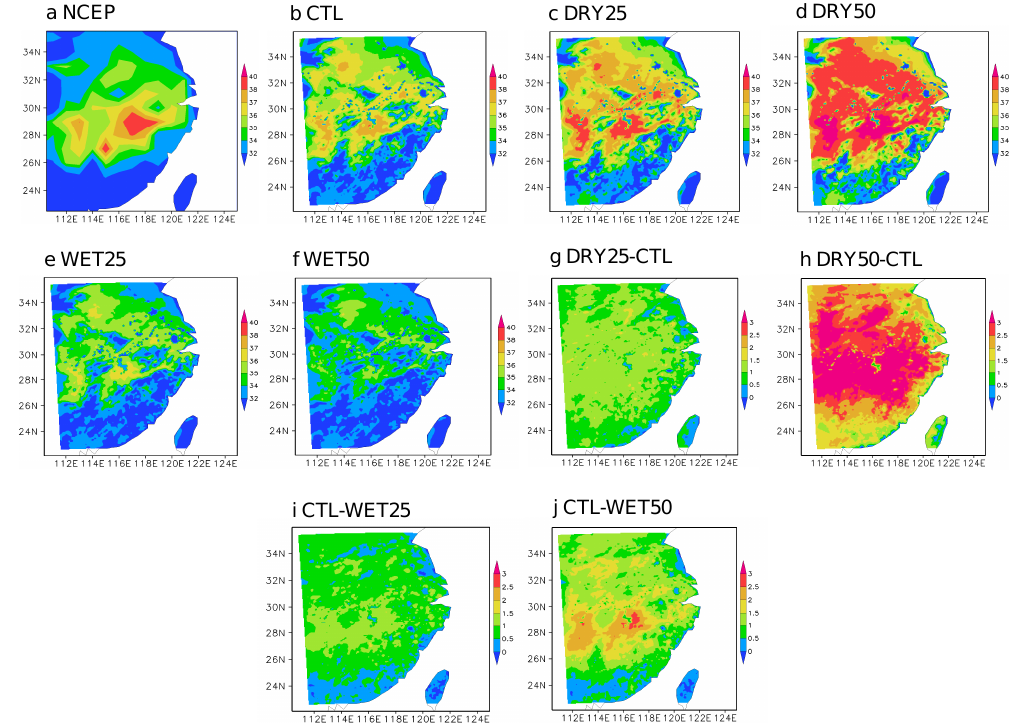
Figure 3. The spatial distributions of the 10-day mean SAT06 in the simulations (unit: ◦